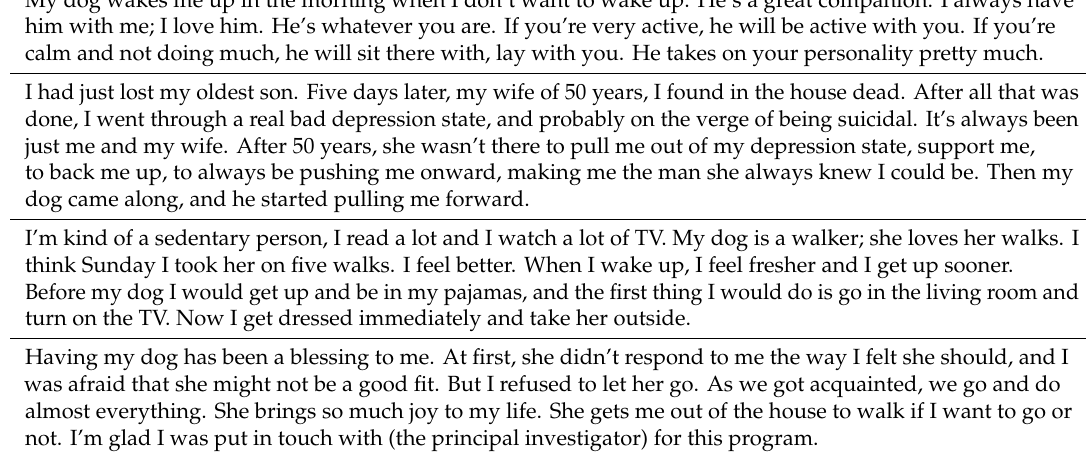
Table 4. Veterans’ Experience with the